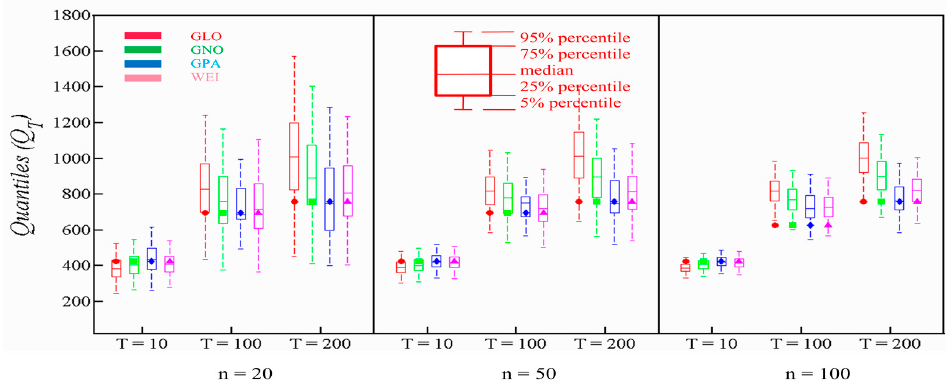
Figure 6. Boxplot for GLO, GNO, GPAand WEI for Shah Alam river.